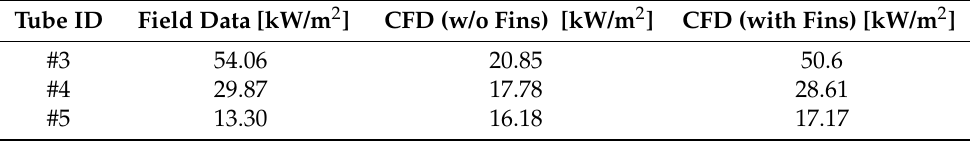
Table 13. Comparison between heat fluxes for field datasheet and CFD model in Second Tubes.